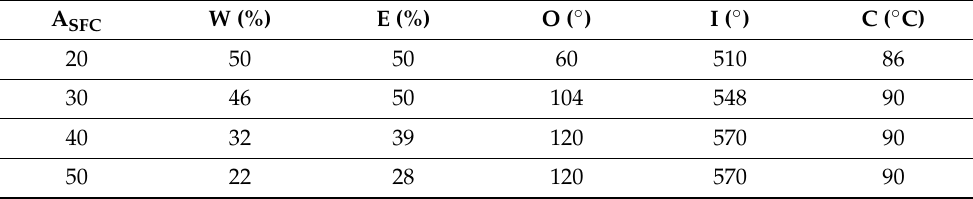
Table 3. Most appropriate option under several criteria weights for the